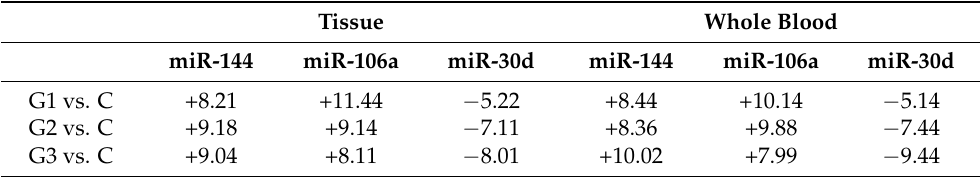
Table 6. Expression profile of miR-144, miR-106a, and miR-30d in endometrial tissue and whole blood of patients with endometrial cancer, compared to a control (presented as fold